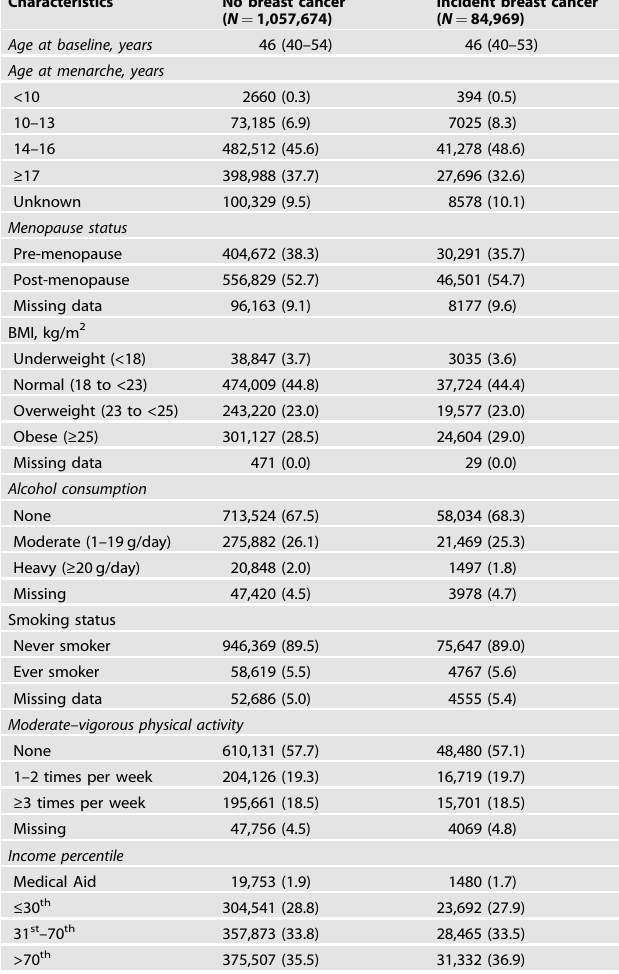
BMI body mass index. Values in the table are medians (interquartile range) or numbers